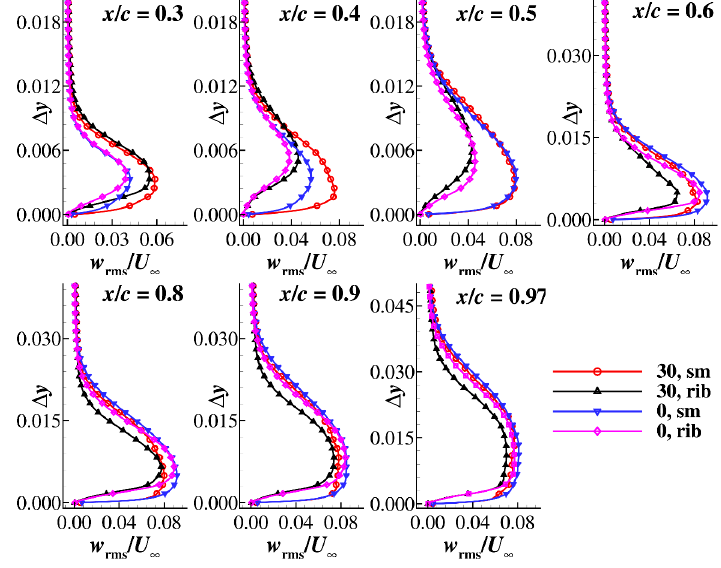
Figure 16. Root mean square of w velocity at the seven locations.